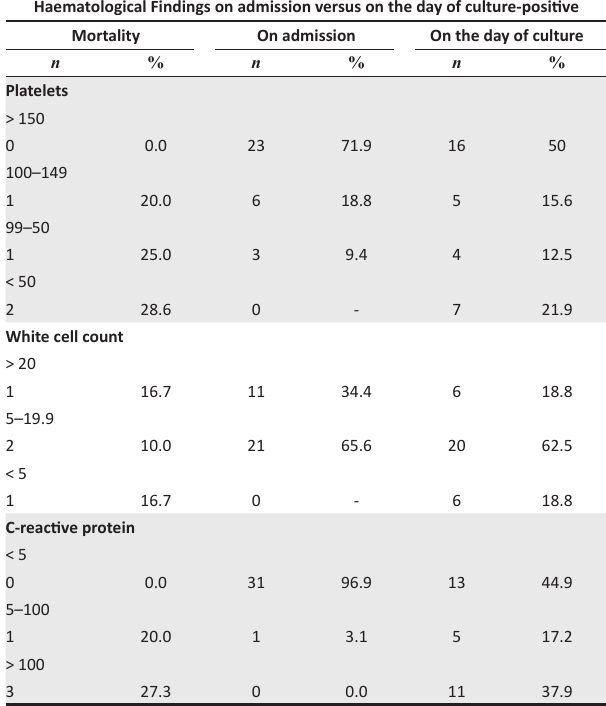
TABLE 2: Haematological finding on admission and day of